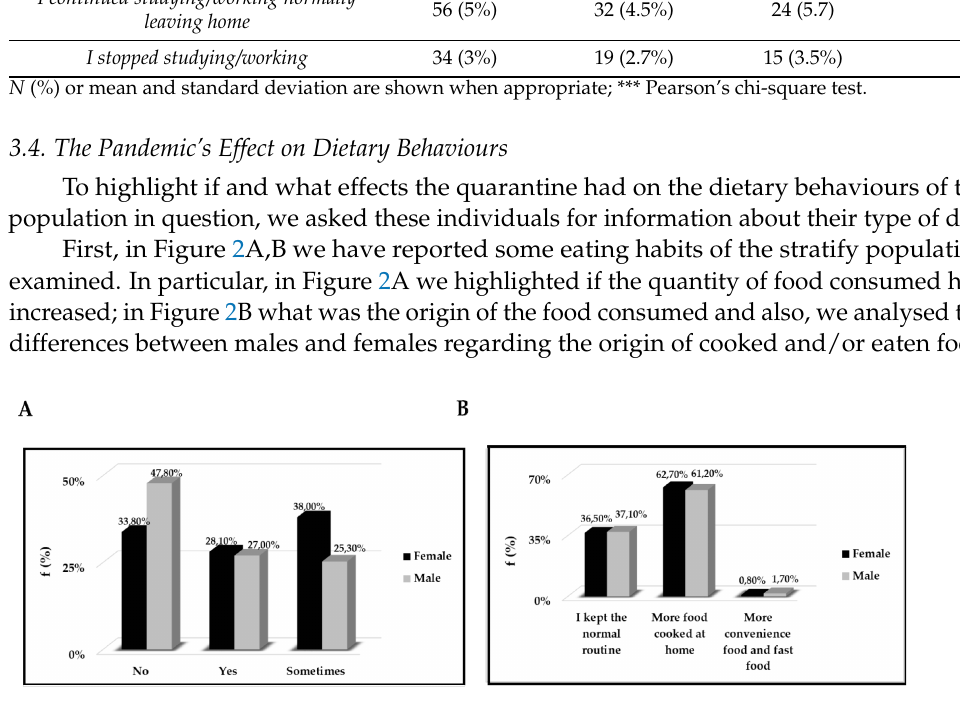
Table 3. The quarantine’s effect on job activity of the university population and stratification by gender.